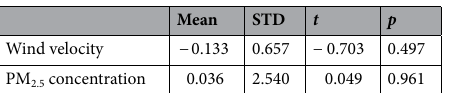
Table 2. Comparisons of measured and numerical results in paired t